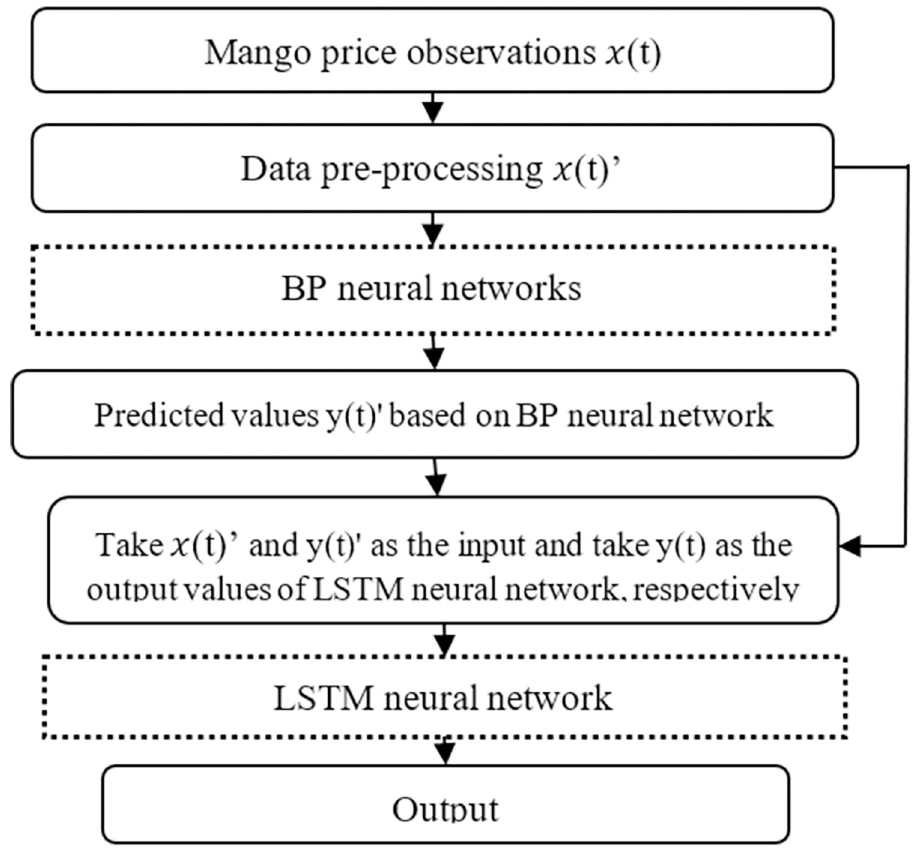
Fig 6. Structure of the combined back-propagation long short-term memory